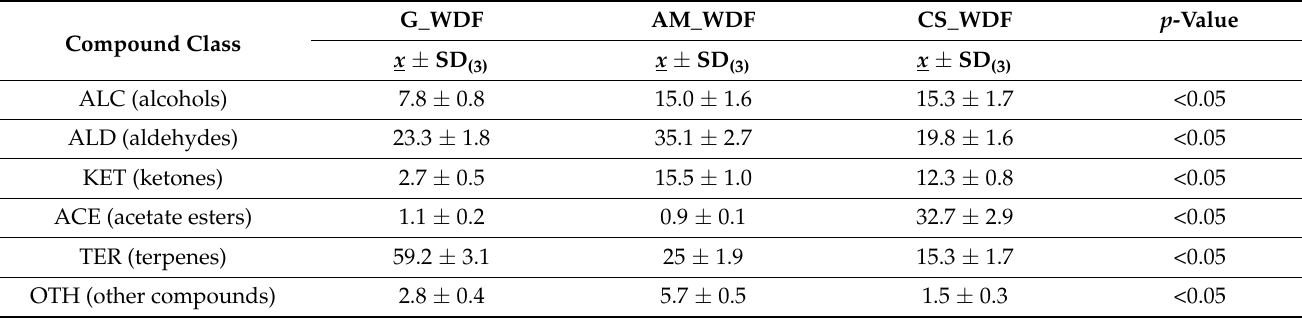
Table 2. Compounds classes # identified in the HS-SPME-GC-MS analysis * of the fiber samples obtained from watermelon pomace.